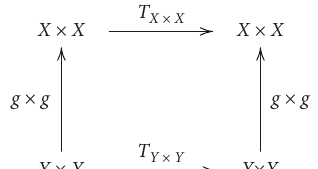
Figure 11: A commutative diagram.